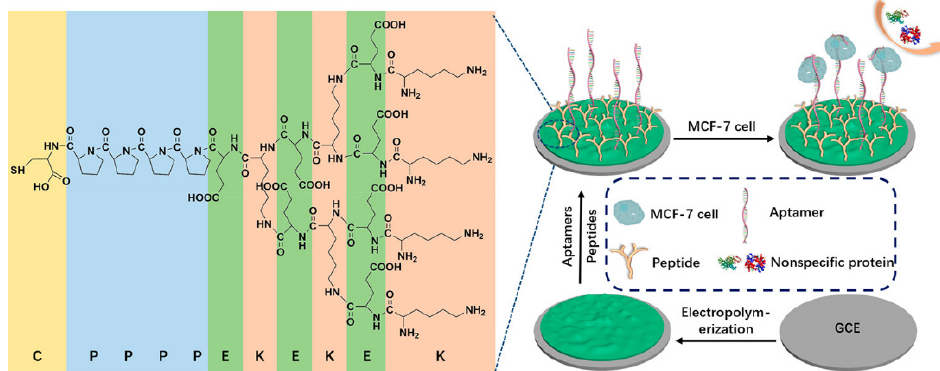
Figure 3. Schematic diagram of antifouling electrochemical-cell-based biosensor. The structure of the synthetic branched peptide is shown on the left. Reproduced with permission from [19], American Chemical Society, 2019.